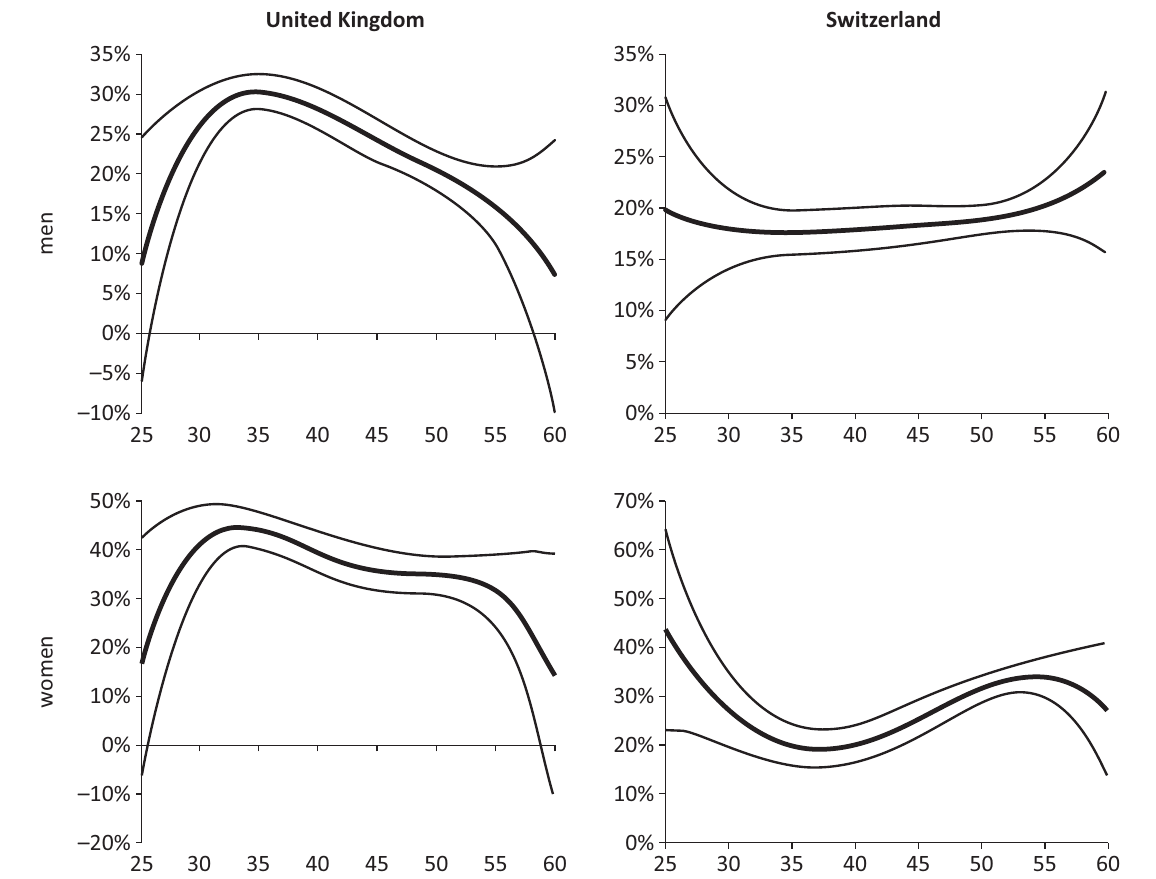
Figure A11. Difference in annual wages by age for upper-secondary vocational relative to lower education (aver- age marginal effects). Source: UK Labour Force Survey 1993–2014 and Swiss Labour Force Survey 1991–2014,